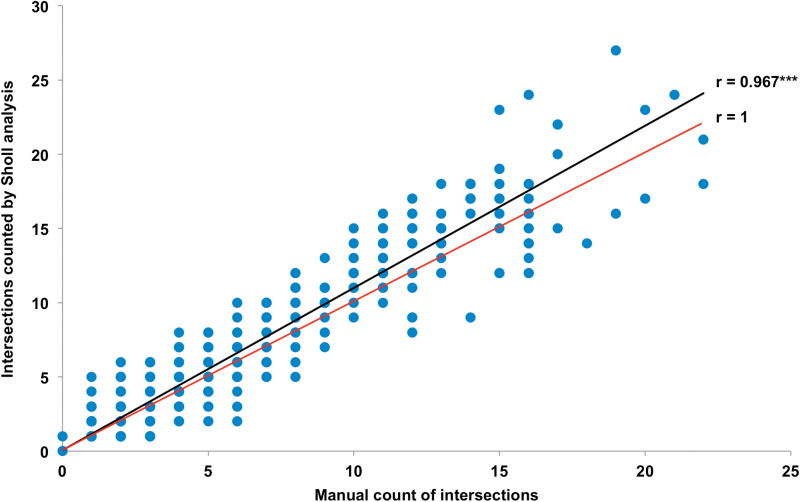
Correlations between the manually counted number of intersections and the number of intersections measured with Sholl analysis. Measurements were done on roots of two different winter oilseed rape genotypes cultivated under control and osmotic stress conditions. Regression lines were indicated for the calculated correlation (r = 0.967) and the maximum possible correlation (r = 1) between manually counted intersections and intersections counted by Sholl analysis. Total sample size: n = 20. Significance at ***P < 0.001 (this figure is available in colour at JXB online).